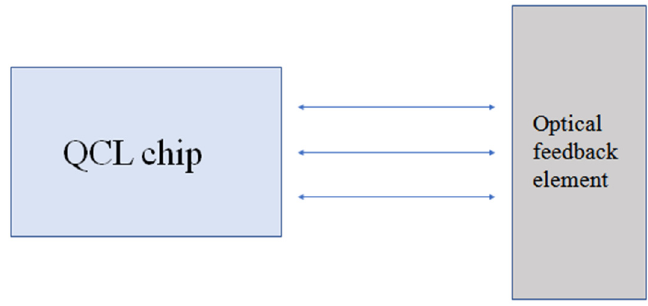
Figure 1. Basic structure of ECQCLs.